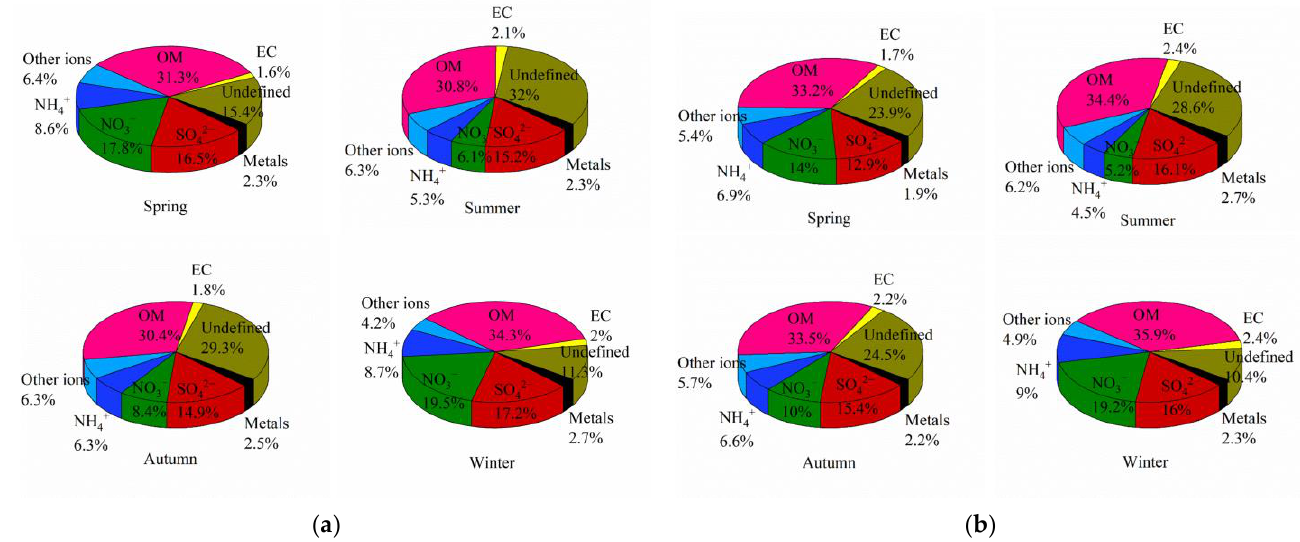
Figure 2. Percentage of each component in PM collected for four seasons: ( a ) PM 2.5 ; ( b ) PM 1 .